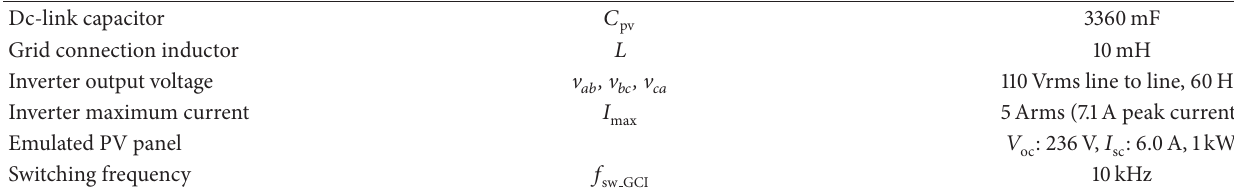
Figure 1: Block diagrams of experimental single-stage three-phase grid-connected PV system. Table 1: Parameters of experimental